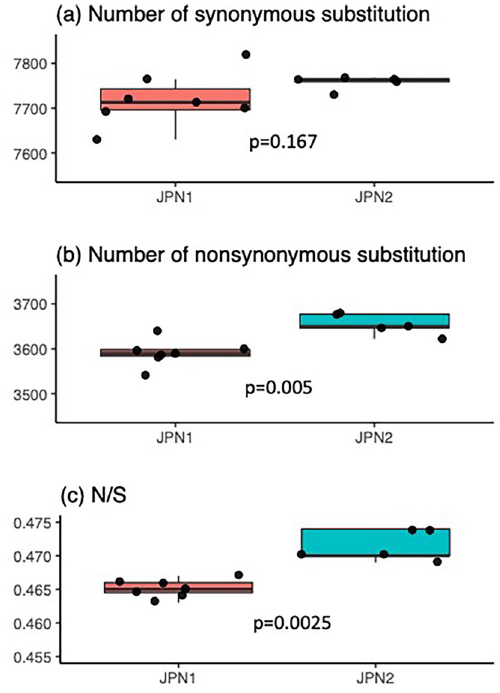
Figure 2. Boxplots showing the numbers of synonymous ( a ) and nonsynonymous substitutions ( b ) and the ratio of these substitutions ( c ) among genotypes of JPN1 and JPN2 lineages. Filled circles show the values of each genotype. The significant probability of difference between the two lineages examined by the Mann– Whitney U test is inserted in each